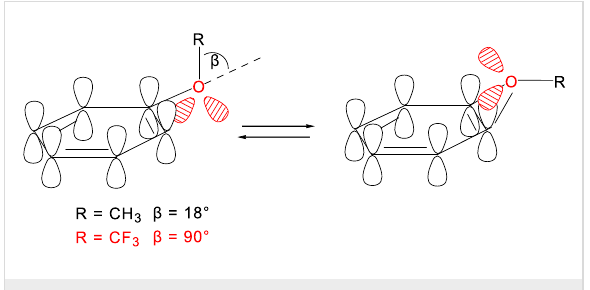
Figure 4: Conformational preference of the trifluoromethoxy group on aryl rings.